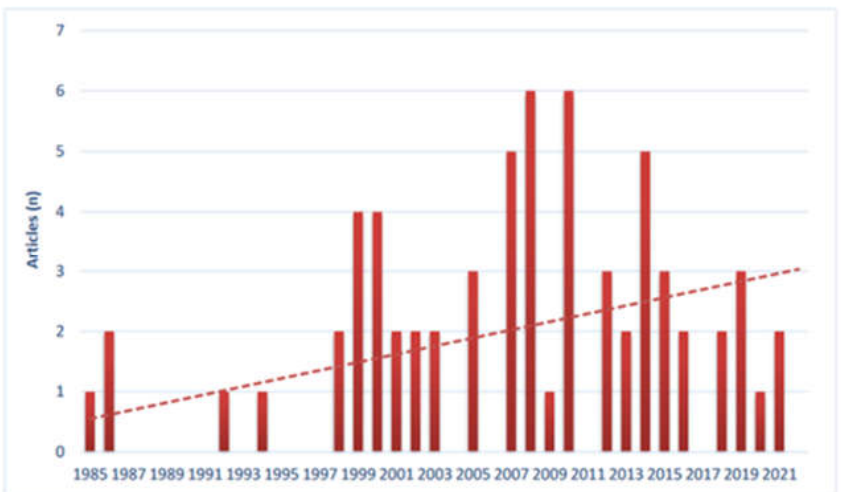
Figure 2. The annual number of documents and trend .